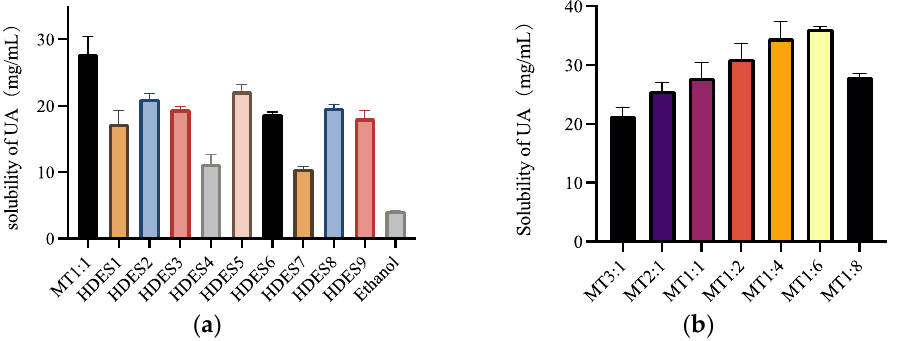
Figure 3. The solubility of UA of HDESs composed of different types of HBA and HBD at 60 °C ( a ), and the solubility of MT1: 6HDES with different HBA and HBD molar ratios at 60 °C ( b